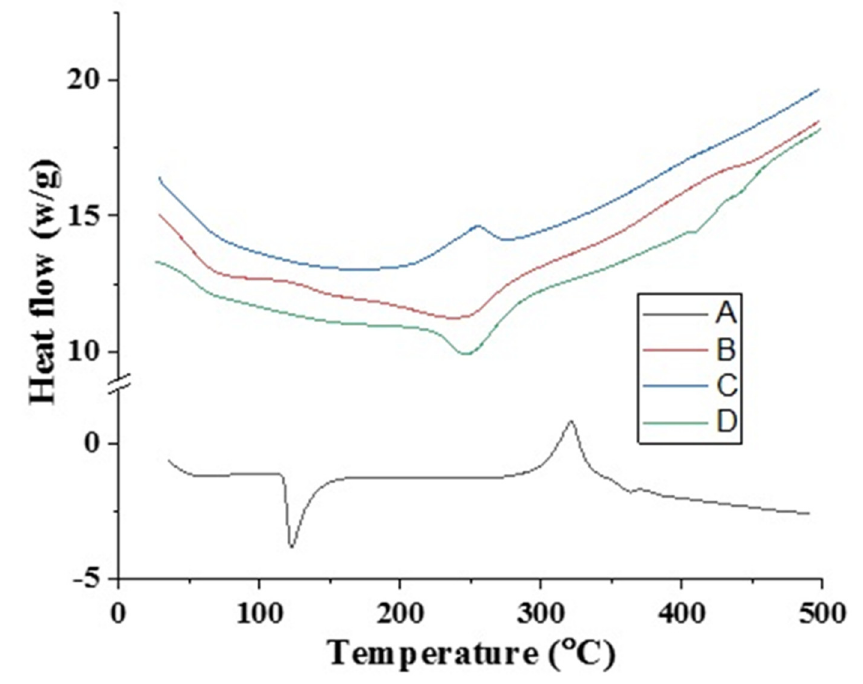
Figure 6. DSC thermogram of ( A ) DF, ( B ) Na-Alg, ( C ) CP-934P, ( D ) DF-loaded Na-Alg/CP-co-poly (MAA) hydrogel.